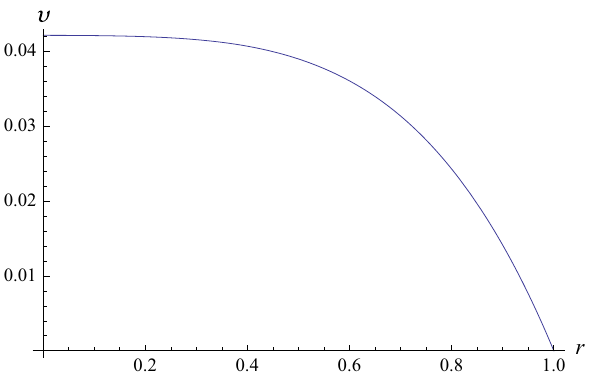
Fig. 4 speed of sound for r = 1 and α = 1 . 95 and b = − 10 . 69 sure and speed of sound are decreasing functions of r , while mass function is increasing. Graphs clearly shows that all quantities are well behaved and physically acceptable